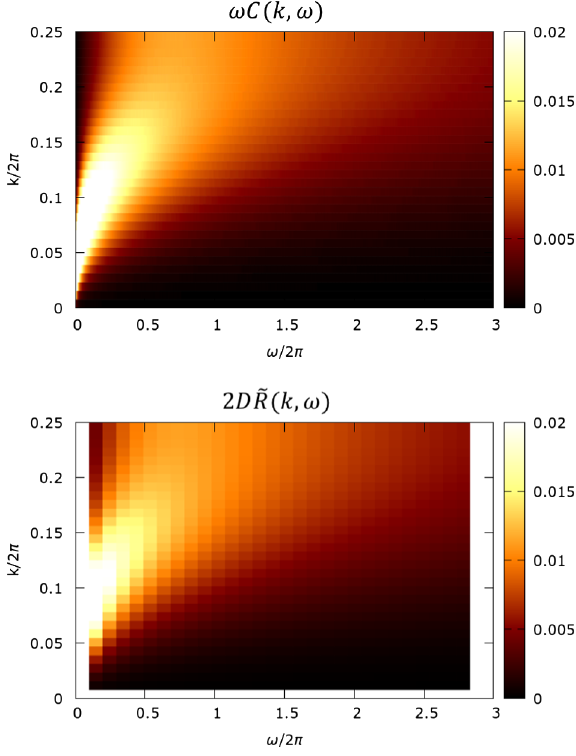
FIG. 4. (a) Correlation ω C ð k ; ω Þ and (b) response 2 DR ð k ; ω Þ for Active Model B in one dimension, found by numerical simulations as detailed in the main text. Parameter values are −